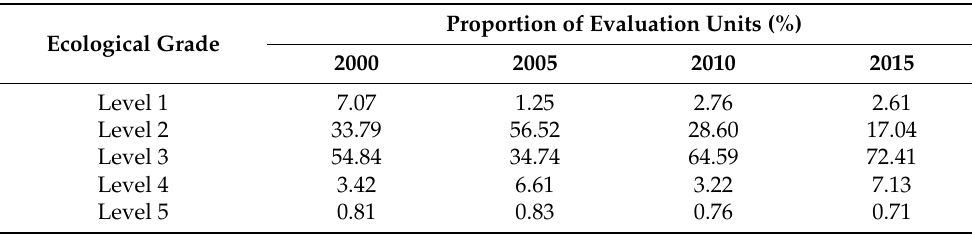
Table 3. The table for the proportion of evaluation units of each ecological level in 2000, 2005, 2010, and 2015.